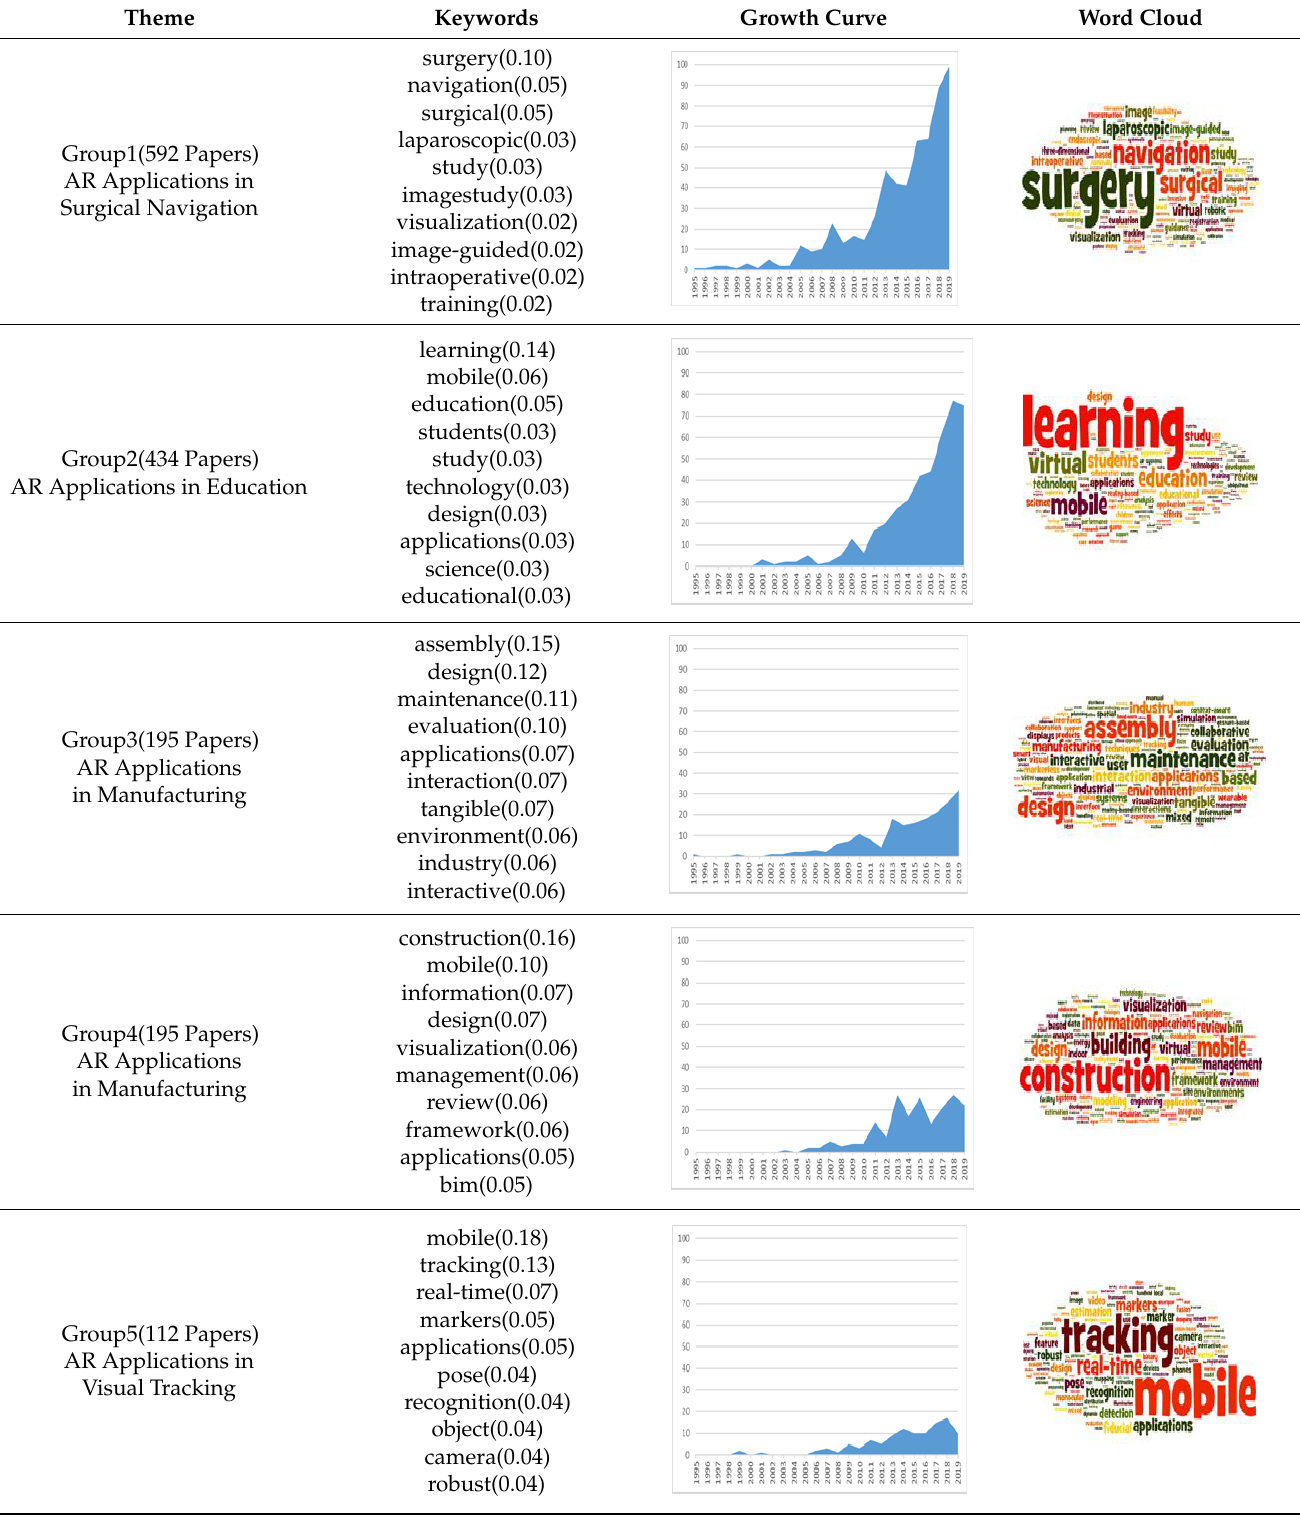
Table 2. Themes, number of papers, keywords, word cloud and growth curve of each identified group.